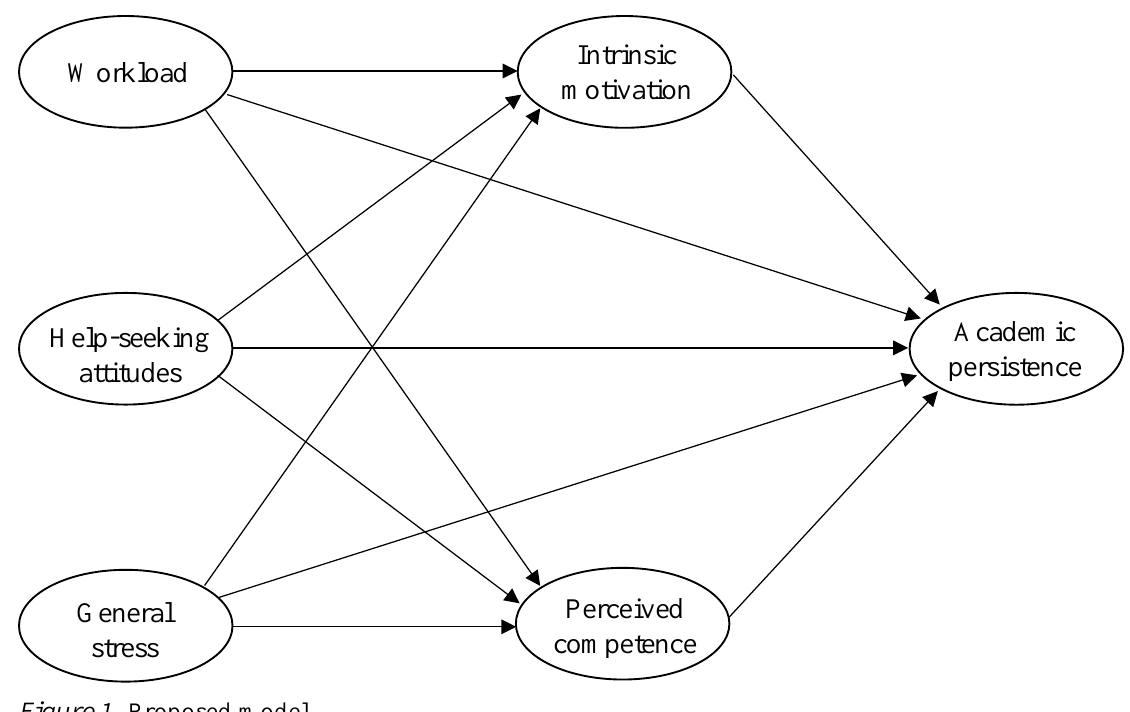
Figure 1 . Proposed